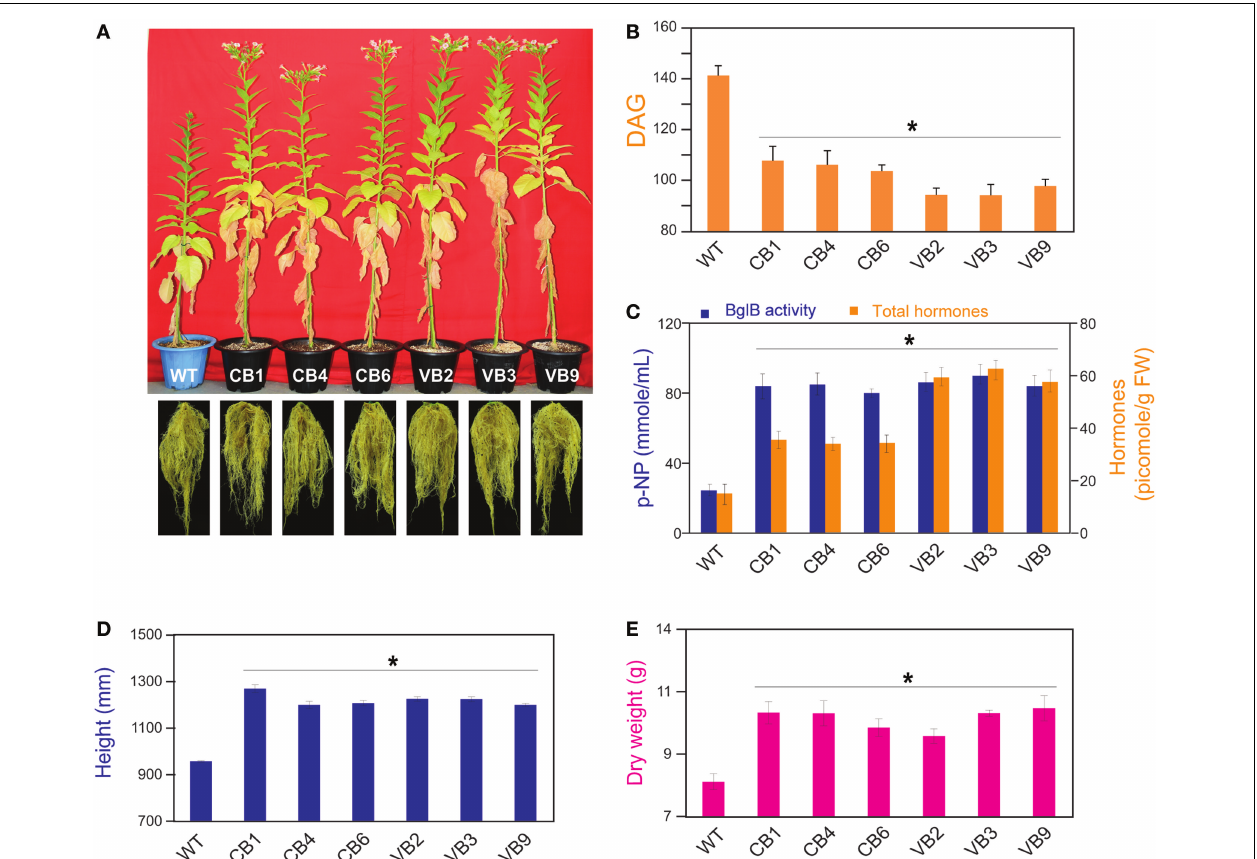
FIGURE 3 | Pronounced phenotypic changes occurred in heterologously expressed BglB transgenic tobacco plants . (A) Faster growth in stem height, shortened growth cycle with earlier flowering, and enhanced root development in the transgenic plants compared to WT plants. (B) Time required from germination to flowering of the transgenic vs. WT plants, showed the shortest time required belong to VB plants. (C) Combination of β -glucosidase enzymatic activity and total hormones levels of the transgenic and WT plants, measured by harvesting the fifth leaf from the top of plant immediately after flowering. (D) Stem height and (E) dry weight of the transgenic and WT plants were calculated after harvesting seeds and freeze-dried. Average values were calculated from data recorded from twenty individuals ( n = 20) of each transgenic lines and WT plants for (B,D,E) , and from triplicate ( n = 3) of each transgenic lines and WT plants for (C) . *indicates significant differences from the control (WT) ( P <